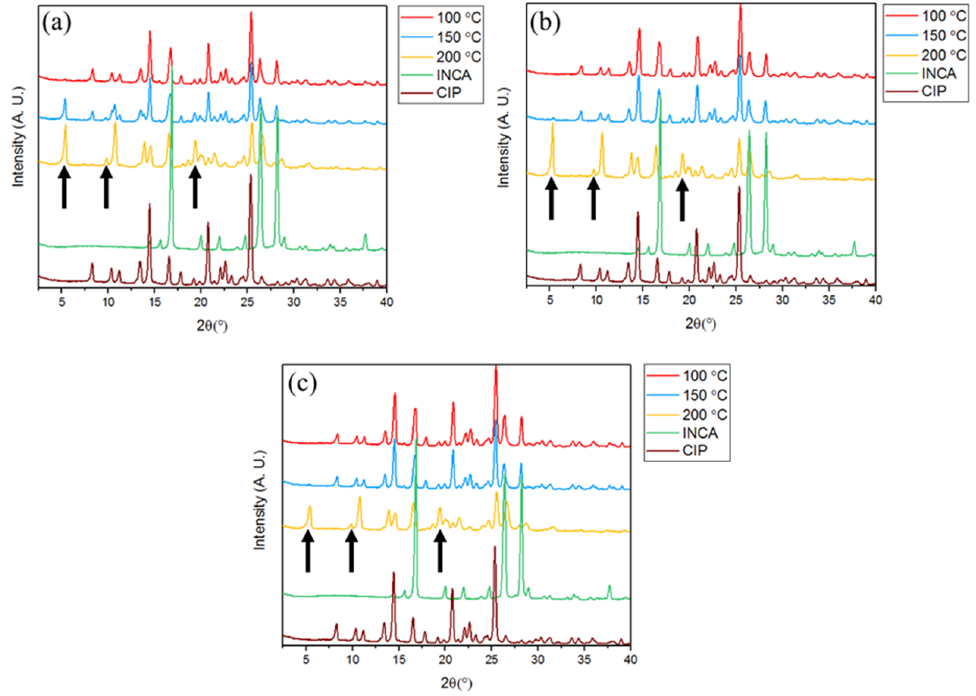
Figure 8. PXRD spectra of samples extruded at various temperature using conveying screw configuration at screw speeds of ( a ) 10 rpm, ( b ) 55 rpm, and ( c ) 100 rpm.